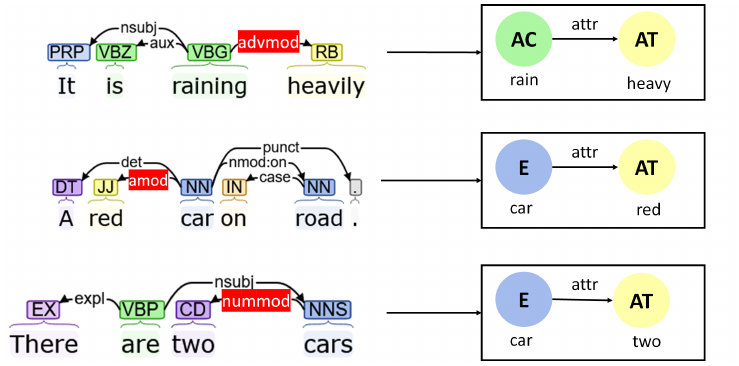
Figure 7. Various ways to directly extract “attr” edges from dependencies.